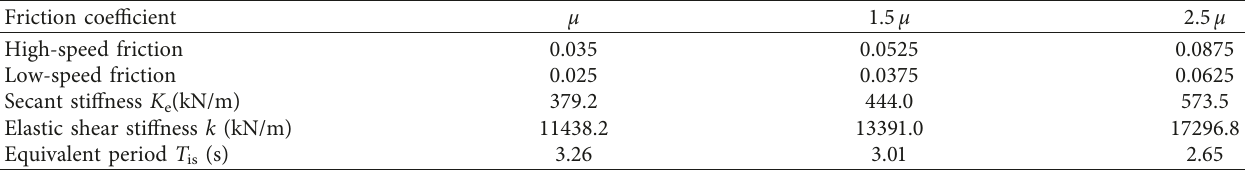
Table 1: Characteristics of sliders.